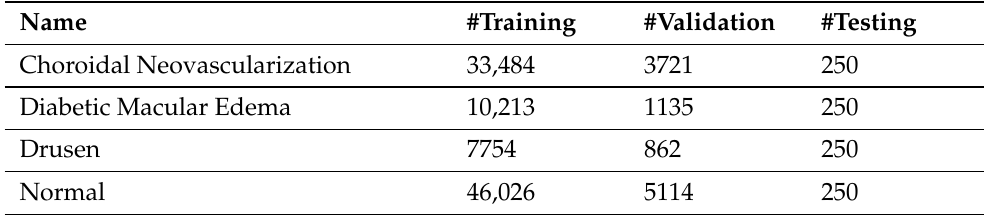
Table 4. Details of OctMNIST